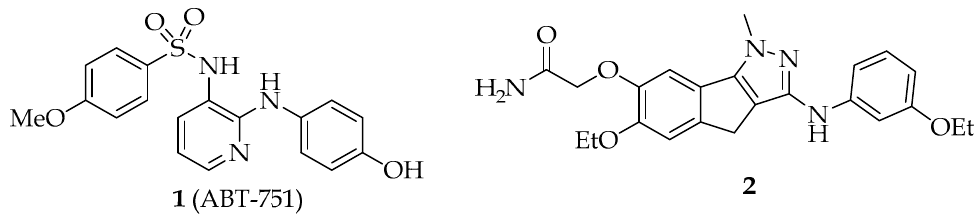
Figure 1. Tubulin inhibitors 1 and 2 .